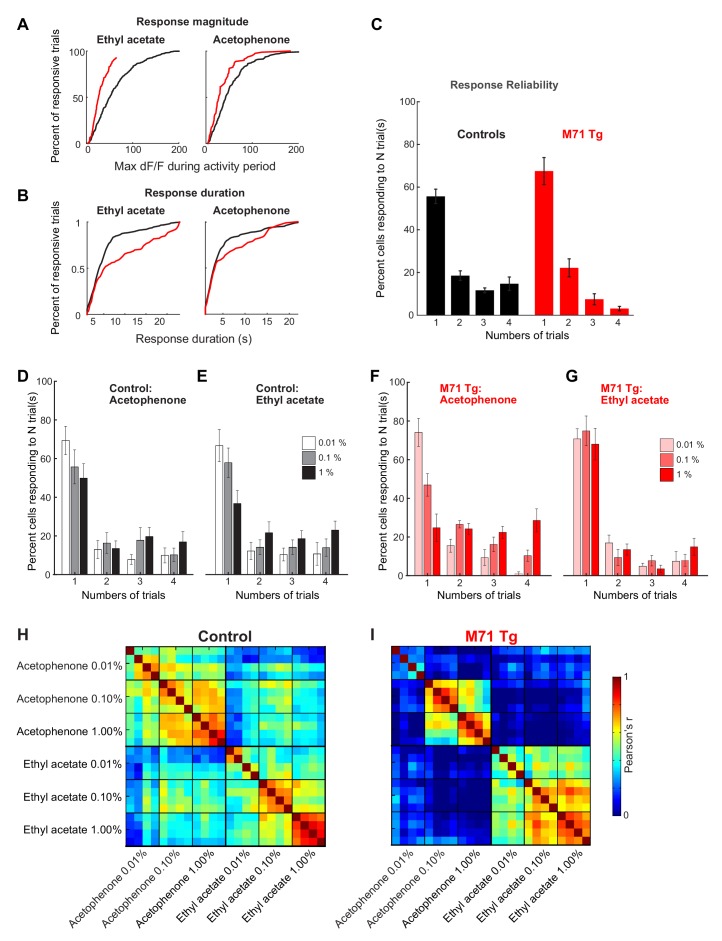
Response magnitudes and durations, and trial-to-trial variability of mitral cell odor responses in M71 transgenic mice.(A–I) Two-photon in vivo imaging of mitral cell odor responses in anesthetized mice. (A) Cumulative frequency plots of the peak F/F values for ethyl acetate- and acetophenone-evoked mitral cell responses in control (black) and M71 transgenic (red) mice. (B) Cumulative frequency plots of response durations for ethyl acetate- and acetophenone-evoked mitral cell responses in control (black) and M71 transgenic (red) mice. (C) Percent of neurons responding to 1, 2, 3, or 4 out of 4 odorant exposures in control (black) and M71 transgenic (red) mice. Note that the fraction of neurons responding on 4 out of 4 trials in strongly reduced in M71 transgenic mice. Error bars = SEM. (D–G) Trial-to-trial variability of mitral cell odor responses decreases with increasing odorant concentrations. (C, D) Percent of neurons responding to 1, 2, 3, or 4 out of 4 odorant exposures to ethyl acetate (D) and acetophenone (E) at increasing concentrations in control mice. (F, G) Percent of neurons responding to 1, 2, 3, or 4 out of 4 odorant exposures to ethyl acetate (F) and acetophenone (G) at increasing concentrations in M71 transgenic mice. Error bars = SEM. (H, I) Pearson’s correlation coefficients for individual acetophenone and ethyl acetate presentations at increasing concentrations. Note that response patterns to acetophenone at increasing concentrations are highly dissimilar from responses to acetophenone at low concentrations, and to responses to ethyl acetate.